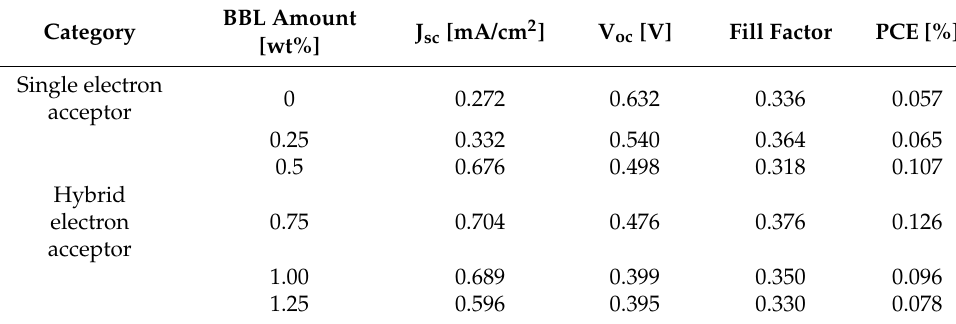
Figure 3. J–V characteristics for solar cells under AM 1.5. Table 1. Solar cell performance under AM